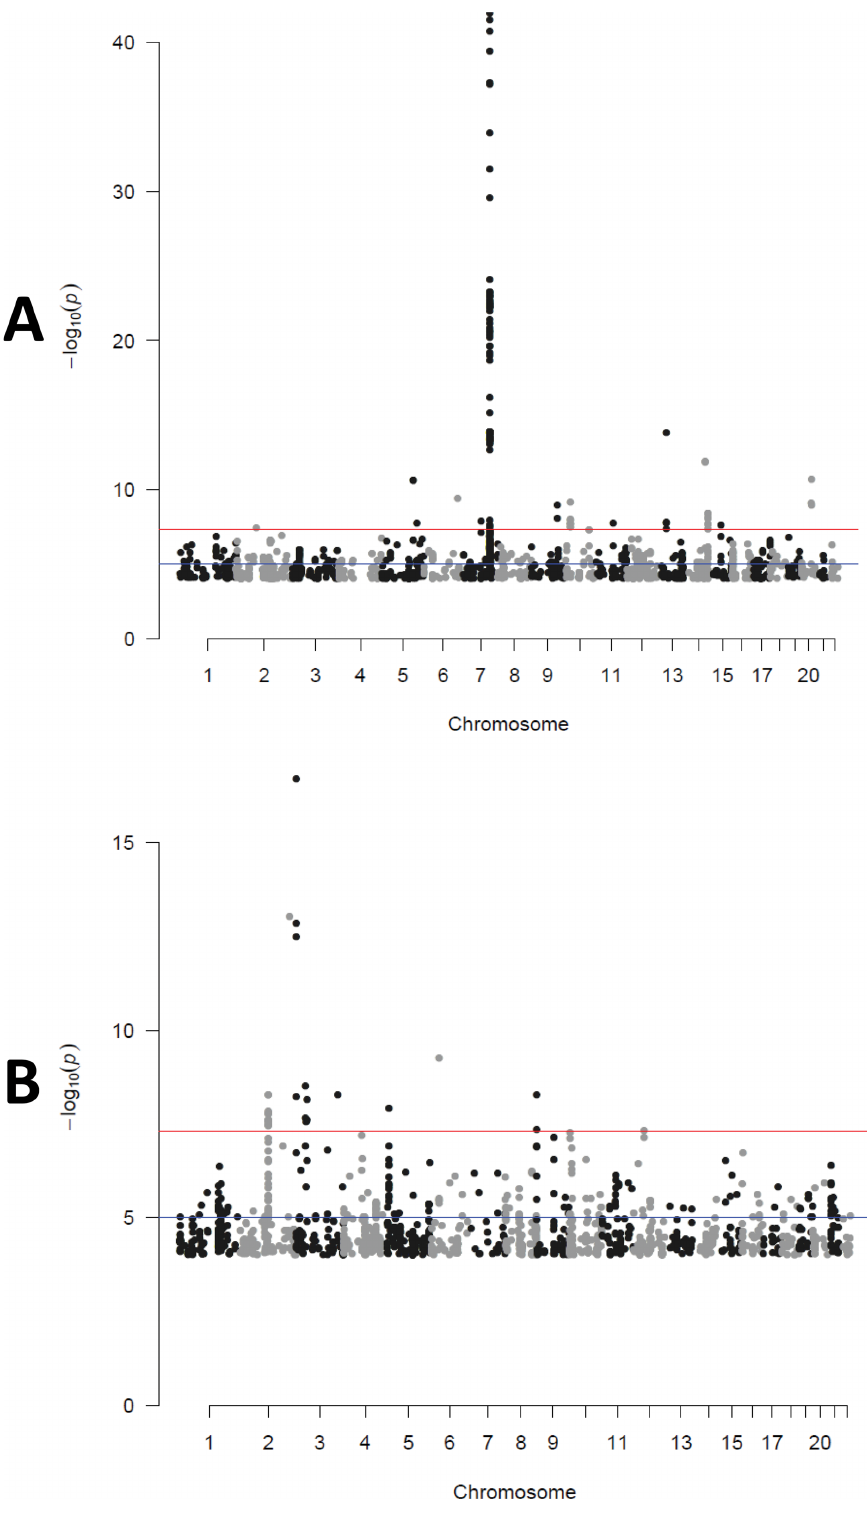
Figure 1. Manhattan plots for two example topics: (A) pulmonary disease/cystic fibrosis-plus and (B)